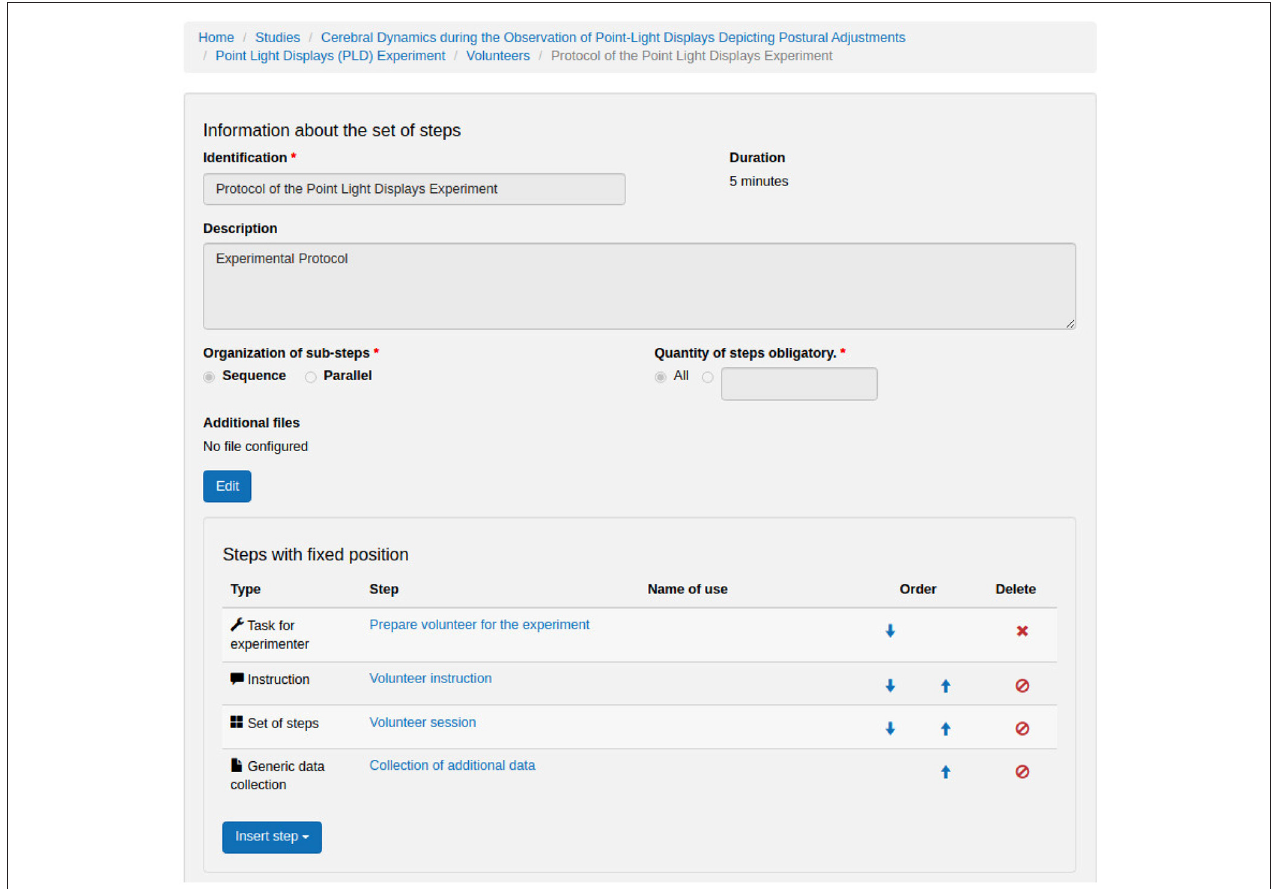
FIGURE 8 | NES graphical interface for registering an experimental protocol for a group of